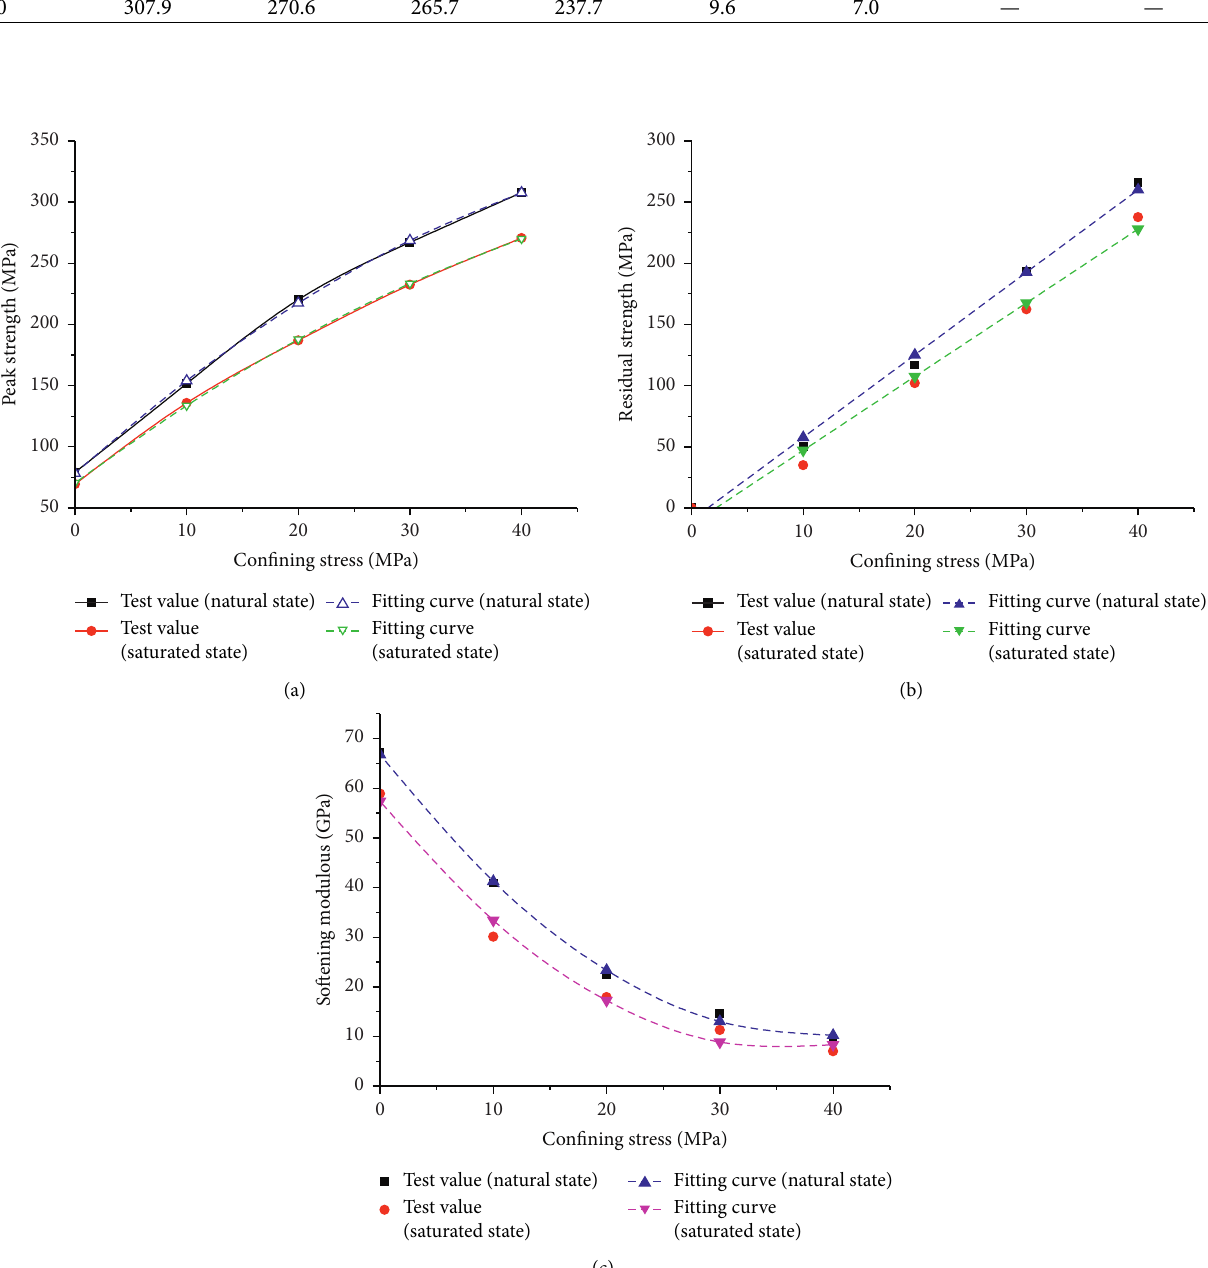
Figure 9: Relationships between peak strength, residual strength, softening modulus, and confining pressure for two water content states. (a) Peak strength versus confining pressure. (b) Residual strength versus confining pressure. (c) Softening modulus versus confining pressure.